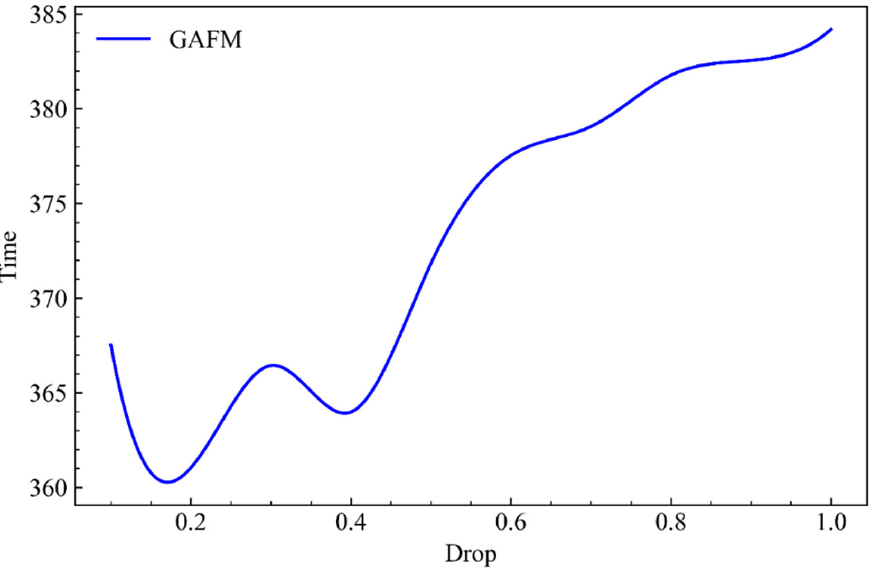
Figure 12. Running time of GAFM under the influence of drop.